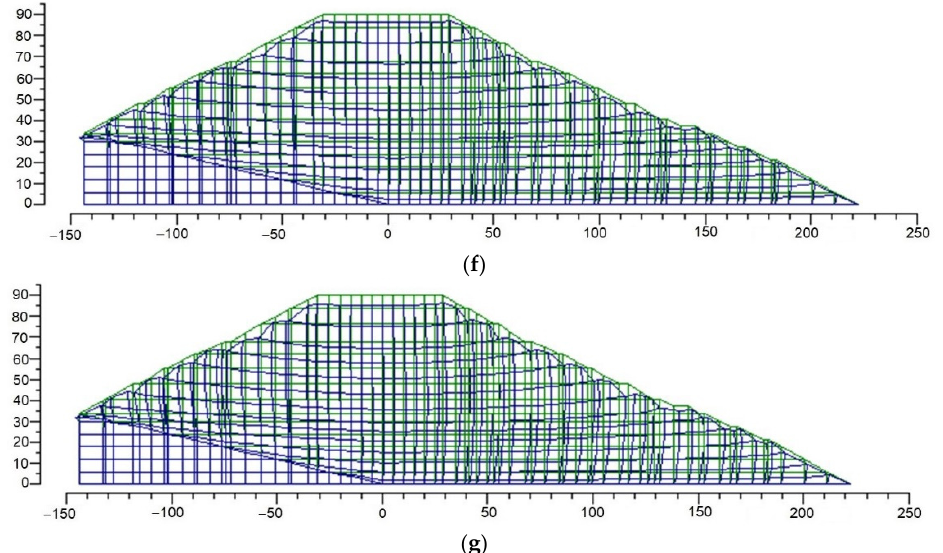
Figure 10. Deformation of embankment at various gravel contents using material constants obtained from one-dimensional compression test (displacements scaled up 25 times): ( a ) P = 0%; ( b ) P = 20%; ( c ) P = 30%; ( d ) P = 40%; ( e ) P = 50%; ( f ) P = 80%; ( g ) P = 100%.